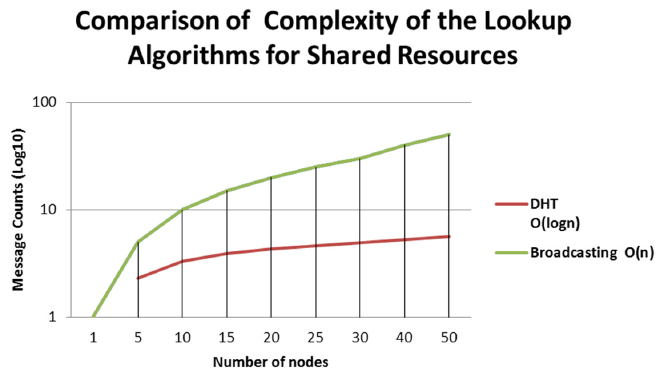
Figure 3. Numerical analysis for comparison of lookup P2P algorithms.